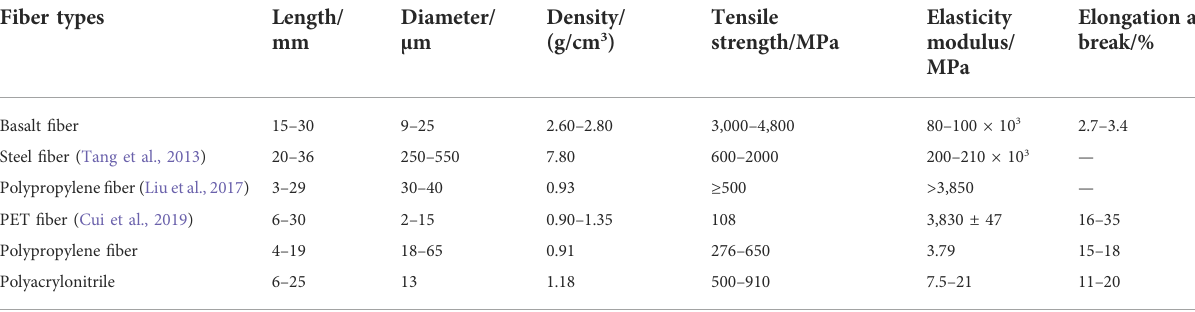
TABLE 1 Fiber types of shotcrete and its material parameter (Cheng and Li,